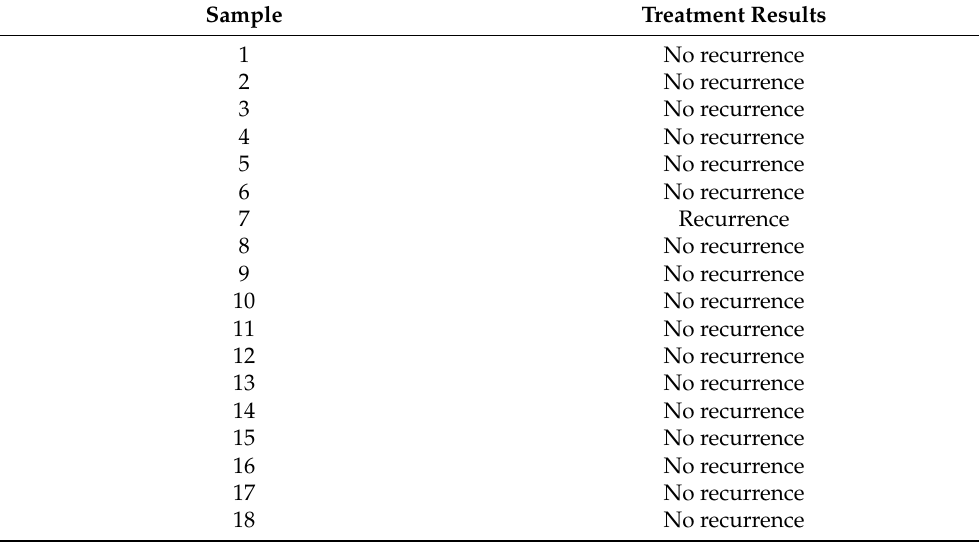
Table 5. The treatment results of